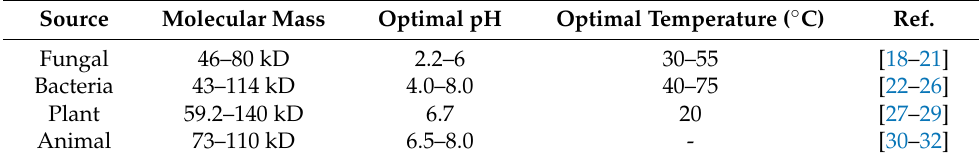
Figure 1. Crystal structure of the laccase (LccI) (PDB code: 1GYC) in Trametes versicolor. ( A ) The overall structure of LccI; ( B ) structure of the schematic representation of the four copper sites in LccI. Table 1. Enzymatic properties of laccase from different sources.